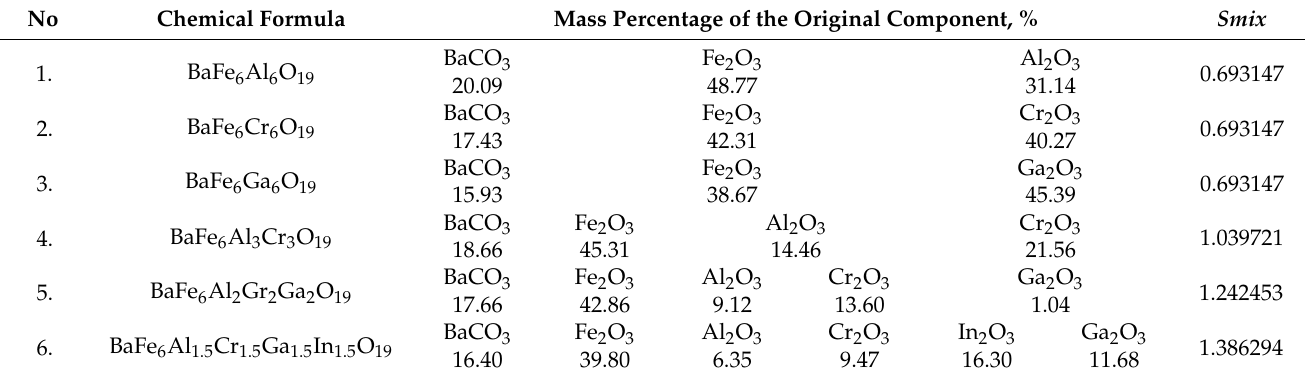
Table 1. Compositions (wt.%) of the initial